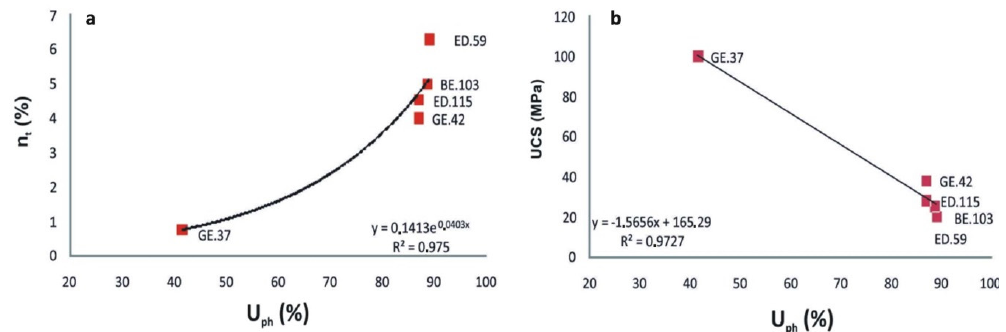
Figure 7. ( a ) The total porosity ( n t (%)) versus the petrographic index ( U ph (%)) of the studied ultramafic rocks; ( b ) the uniaxial compressive strength test ( UCS (MPa)) versus the petrographic index ( U ph (%)) of the studied ultramafic rocks.